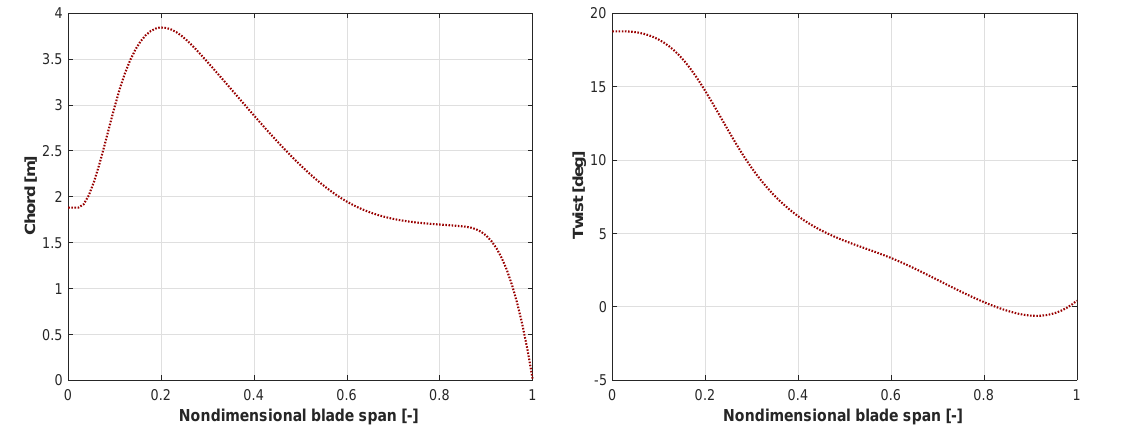
Figure 3. Baseline chord and twist distributions for the 2.2MW wind turbine blade.